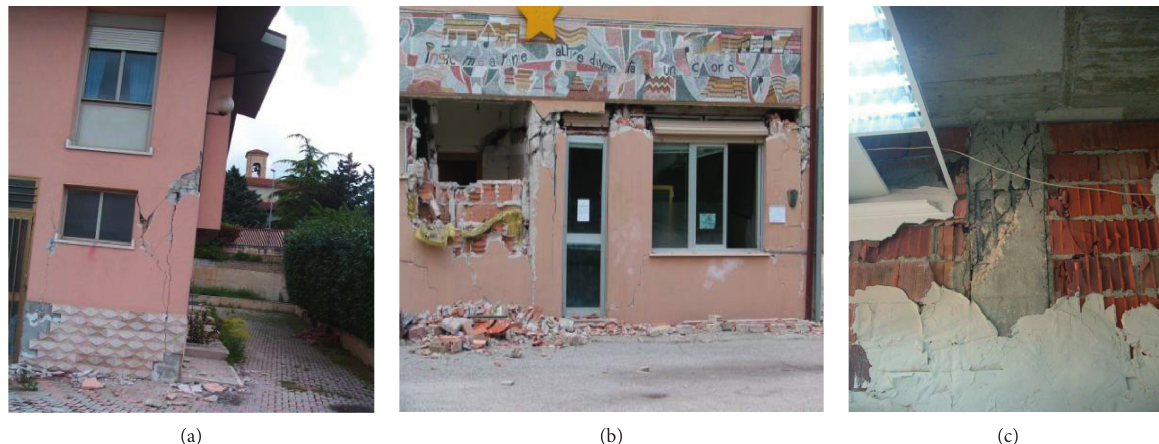
Figure 4: Example of in-plane shear interaction between infill panels and RC frames adapted from [7, 24]. (a) L’Aquila (2009). (b) L’Aquila (2009). (c) Lorca